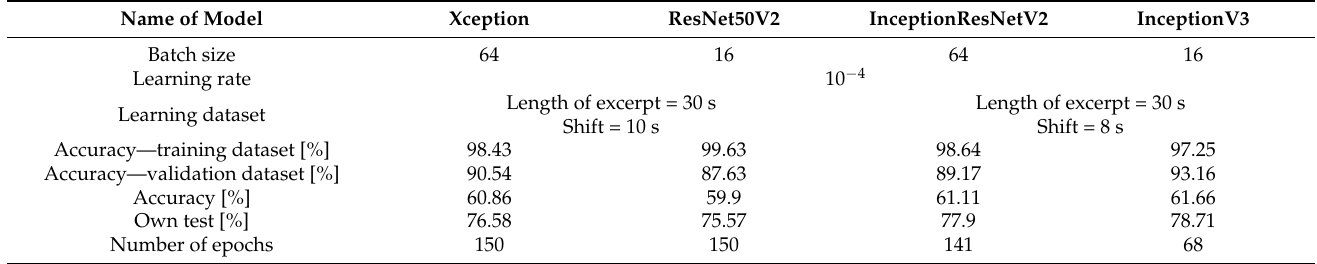
Table 10. Results of the fourth stage of the NN training.